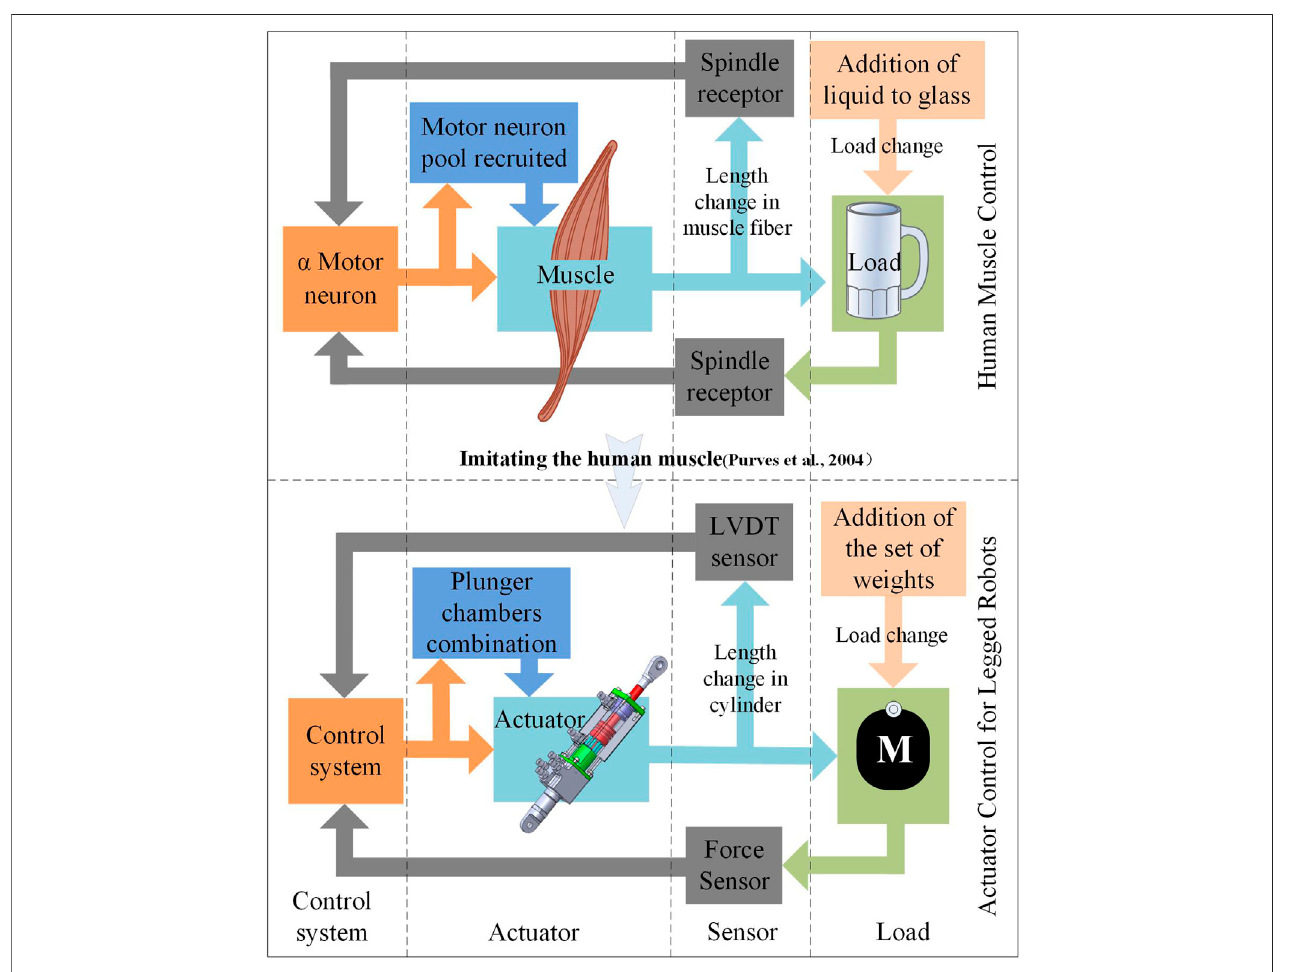
FIGURE 3 | Control mode of the muscle and new